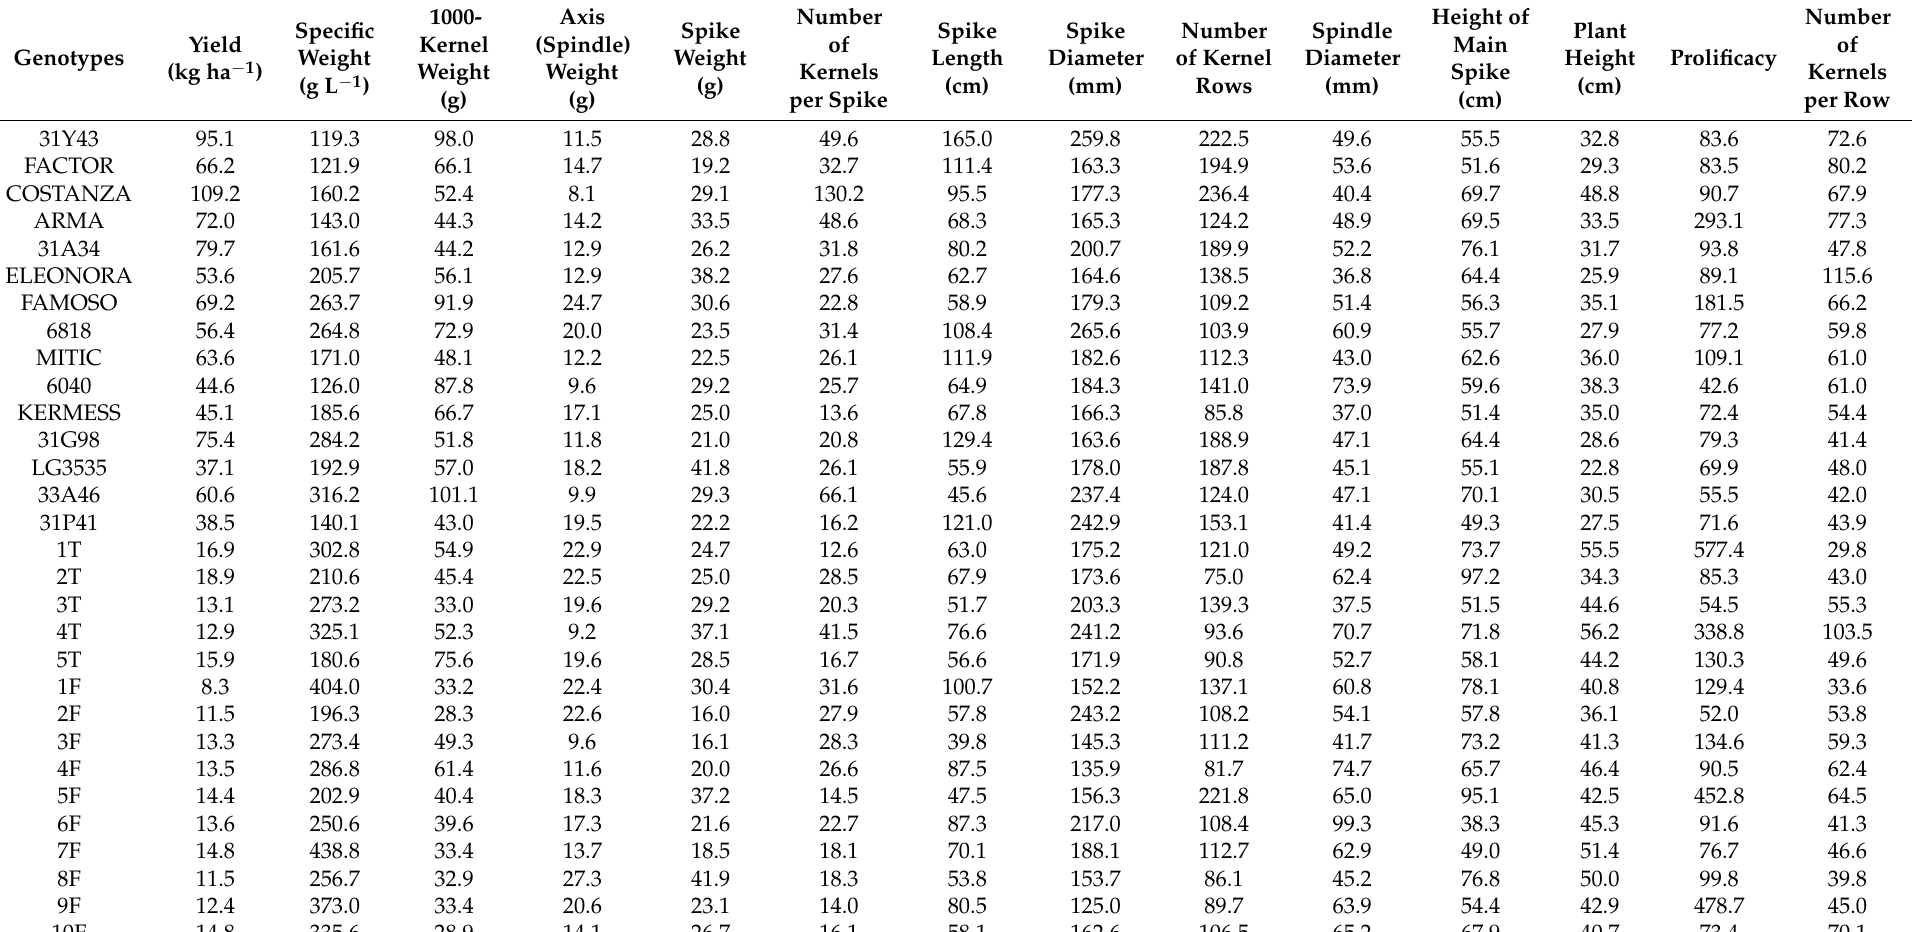
Table 7. Trait stability index ( x / s ) 2 across genotypes for tested traits: yield (kg ha − 1 ), specific weight (g L − 1 ), 1000-kernel weight (g), axis (spindle) weight (g), spike weight (g), number of kernels per spike, spike length (cm) and diameter (mm), number of kernel rows, spindle diameter (mm), main spike and plant height (cm), prolificacy, and number of kernels per